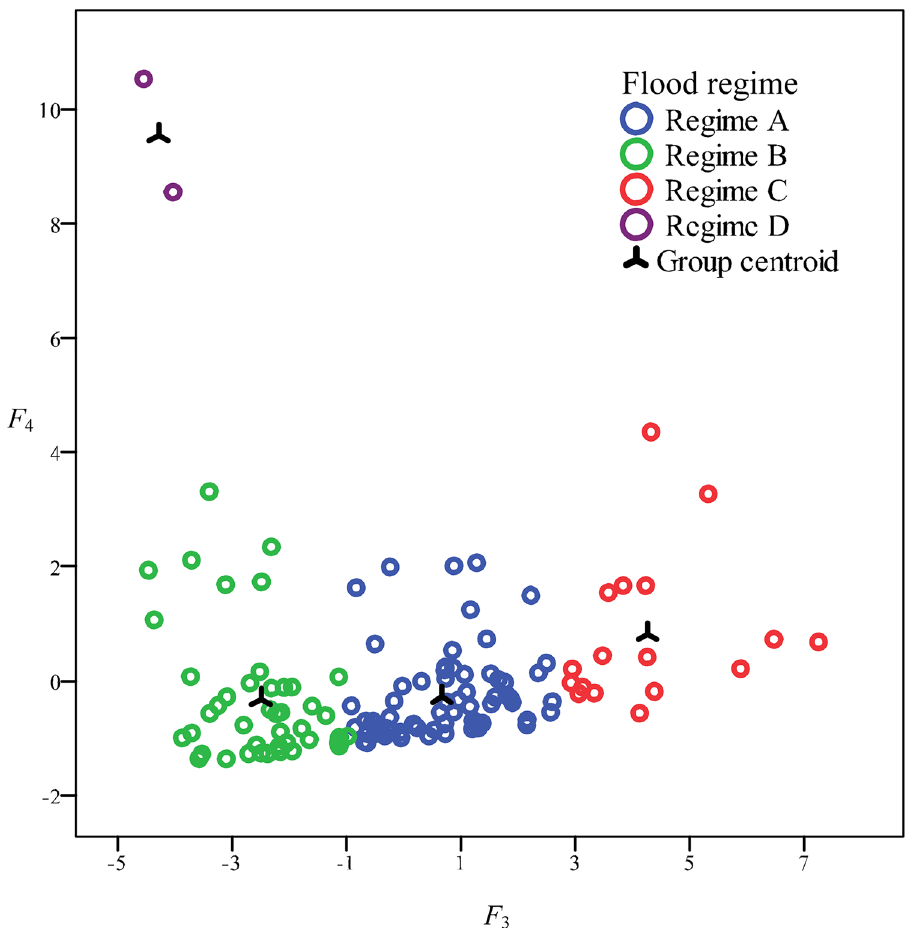
Figure 3. Discriminant analysis of different flood regimes in 1961–1990 (excluding 1971). F 3 and F 4 represent the scores of discriminant functions. Regime A: short flood duration and low erosive energy; Regime B: short flood duration and high erosive energy; Regime C: long flood duration and low erosive energy; Regime D: long flood duration and high erosive